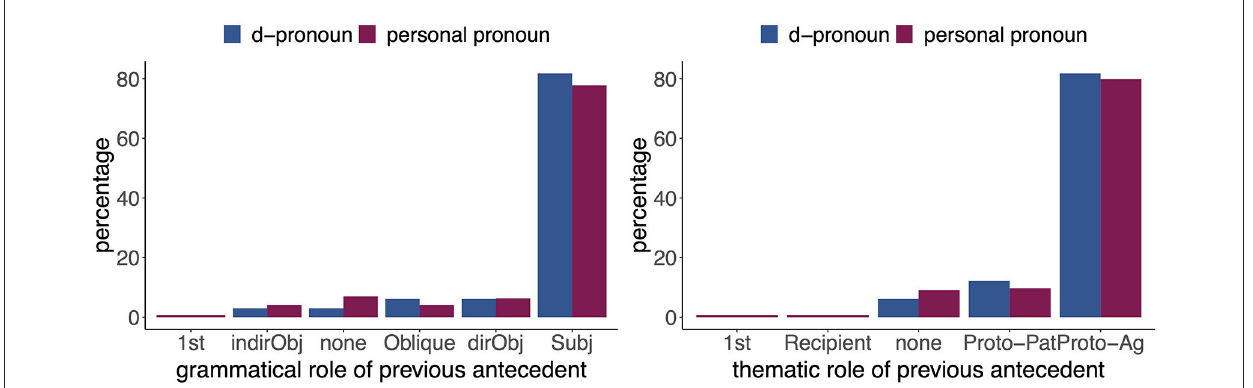
FIGURE2 Distribution of grammatical role (Left) and thematical role (Right) of the antecedents of the personal pronouns (red, n = 181) and d-pronouns (blue, n =